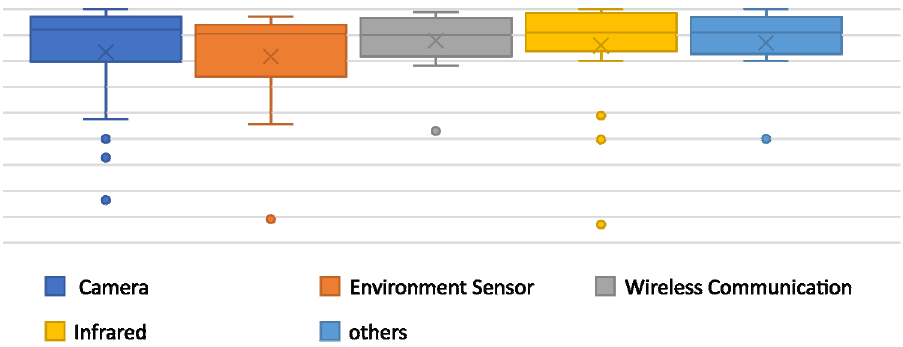
Figure 8. Box plot of occupancy measurement system usage accuracy.